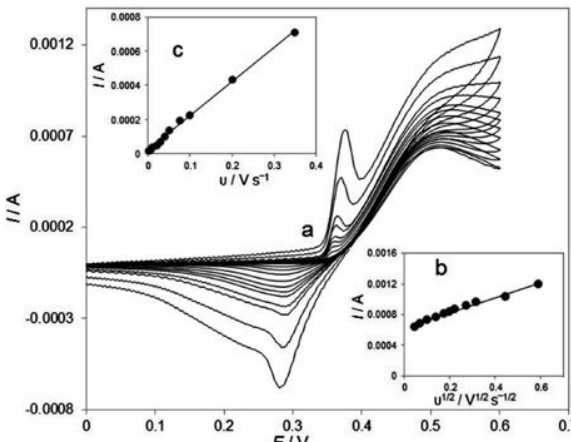
Figure 6. (a) Typical cyclic voltammograms of the Ni-Cu in 1 M NaOH in the presence of 0.5 M ethanol at various scan rates of 2, 5, 10, 20, 30, 40, 50, 75, 100, 200 and 350 mV s –1 . (b) Dependence of anodic peak current at 530 mV on the square root of scan rate. (c) Dependence of anodic peak current at 370 mV on the scan